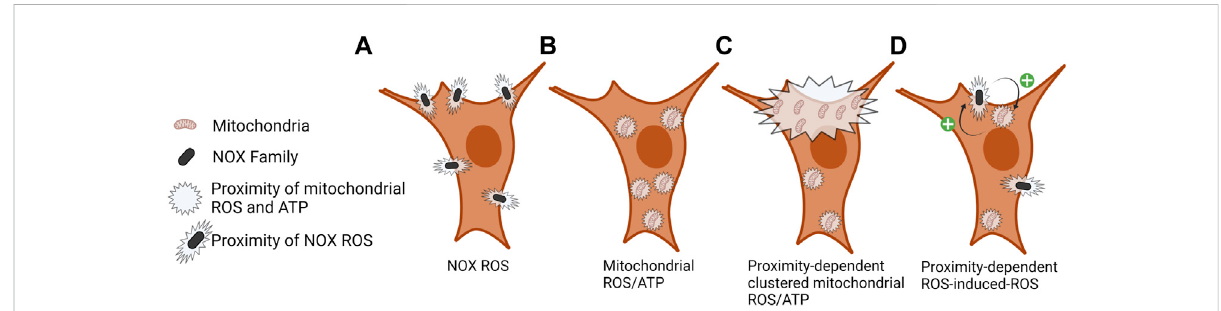
FIGURE 2 Local proximity of NOX ROS and mitochondrial ROS/ATP. (A) ROS is produced by NOX enzymes in the extracellular space proximal to the plasma membrane, signaling at the cytoplasmic face of the plasma membrane is dependent on local ROS concentration and ROS scavenging. (B) MitochondrialROS(mROS)andATParerapidlyconsumedatthesiteofproduction;therefore,thedensityofthesemitochondrialoutputsislocalized tositesofmitochondrialdensity. (C) ClusteringofmitochondriaatsubcellularsitescontributestoalocalizedincreaseinROSandATPlevels. (D) ROS-induced-ROS and mitochondrial – NOX crosstalk regulates the activity of each entity and the amount and duration of ROS production. Still unclear is how the proximity of NOX and mitochondria might regulate this